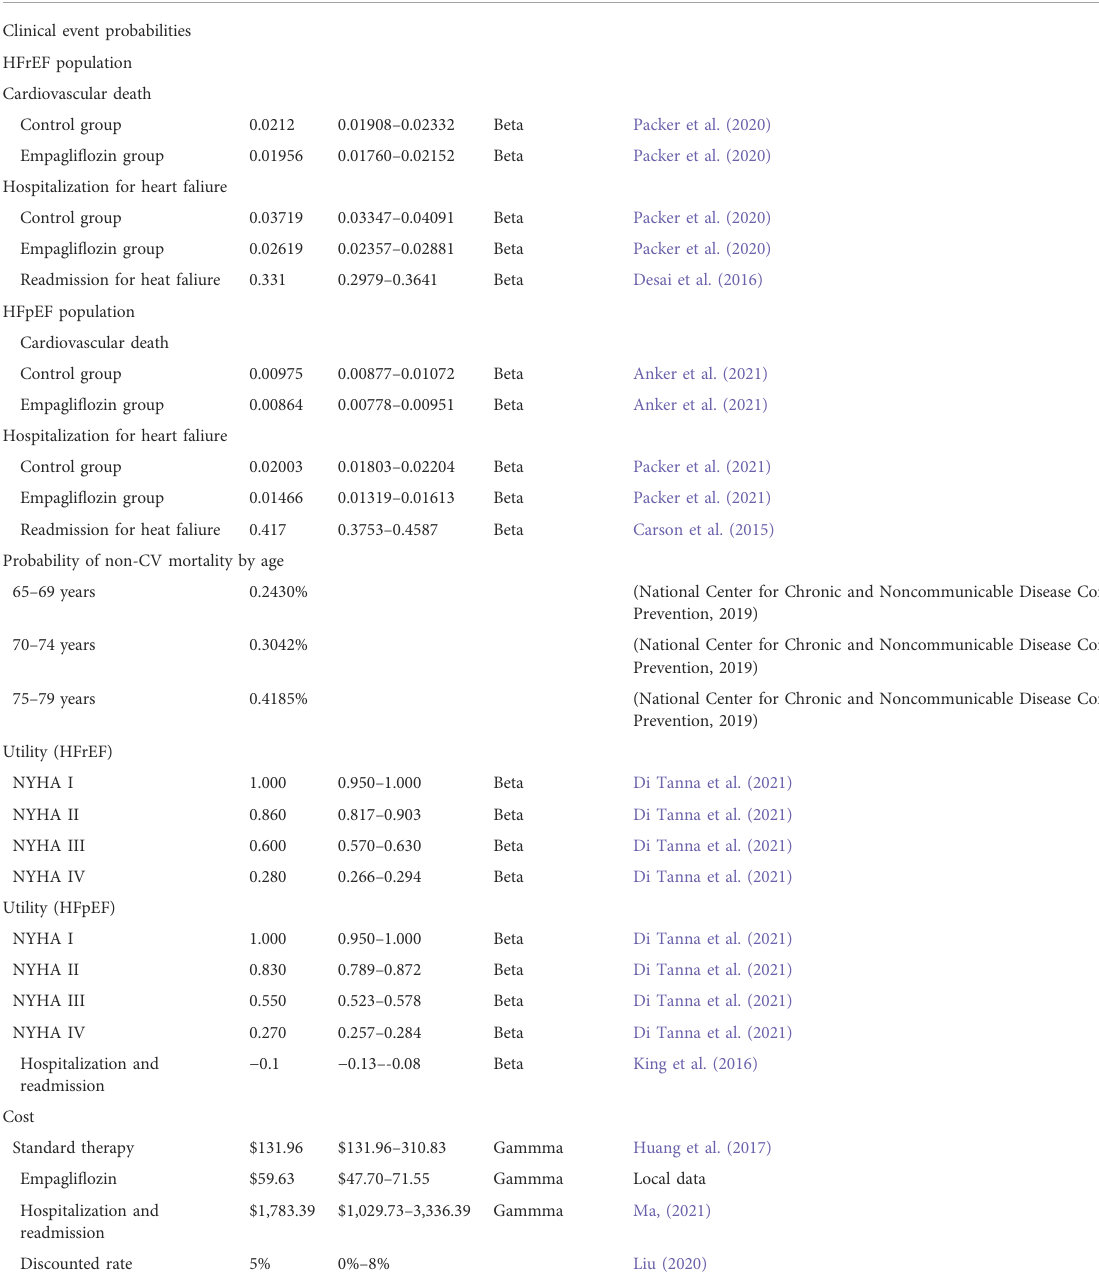
TABLE 1 Selected model